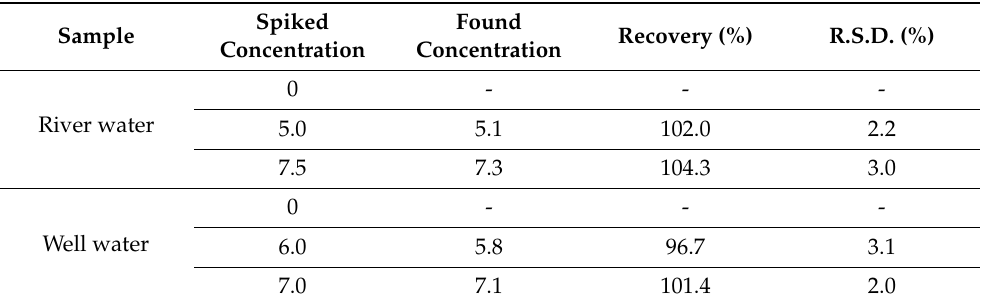
Table 2. Electrochemical determination of hydroxylamine in various water samples with the PPy NTs/GSPE. Concentrations are reported as µ M ( n =